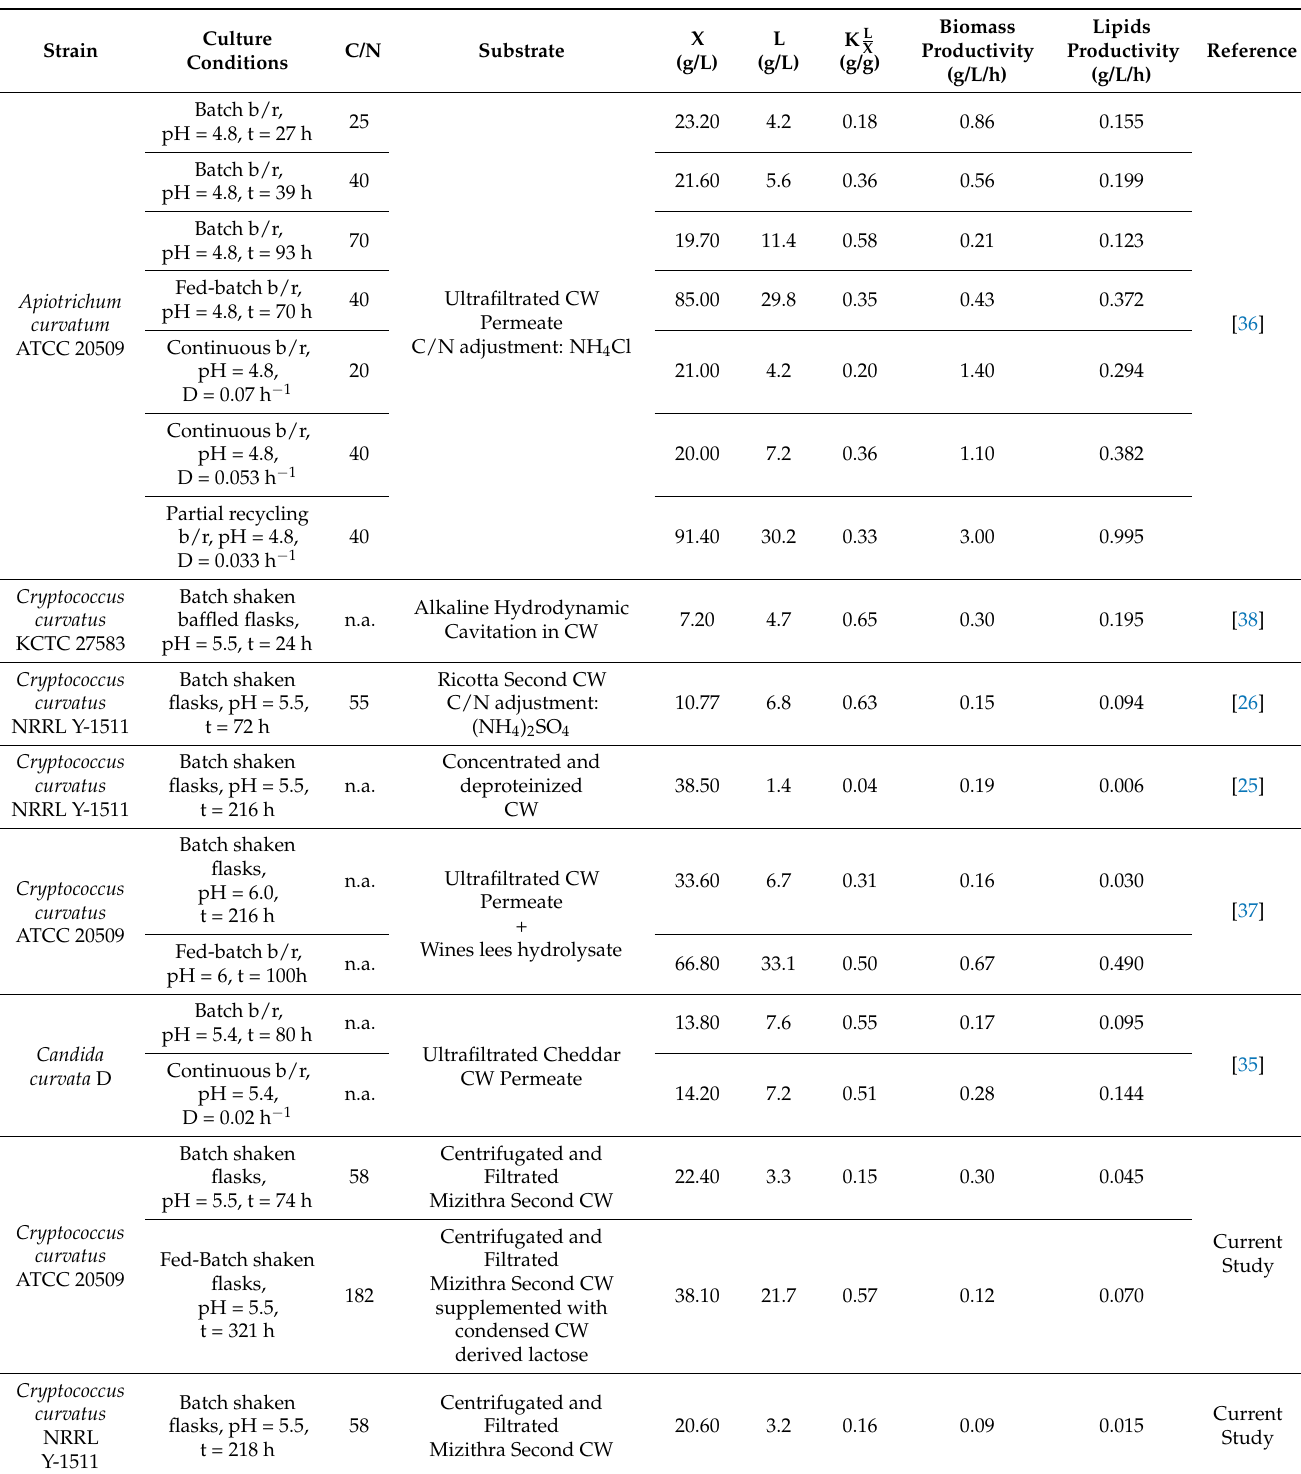
Table 6. Literature review and comparative evaluation regarding to biomass and lipid production and biomass and lipid productivity by oleaginous yeasts, cultivated on pre-treated cheese whey substrate. Comparisons with the present